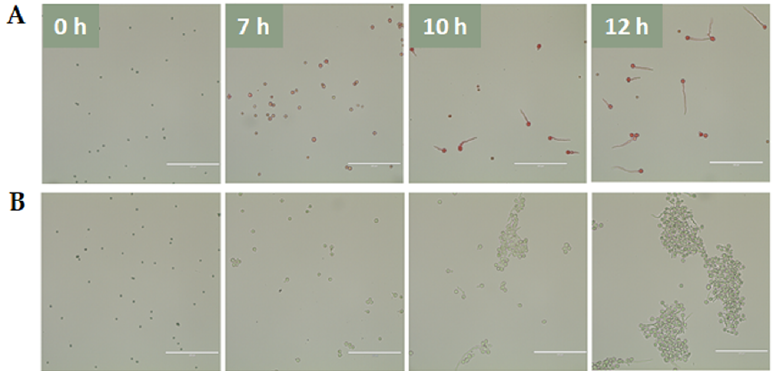
Figure 8. Germination of T203 conidia imaged at four time points (white numbers). Germination in ( A ) 0.5 mM Congo Red and ( B ) PDB. Scale bar: 100 µm for all images.